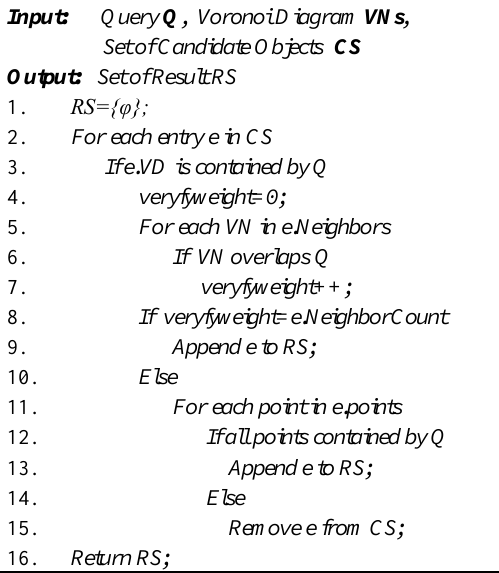
Algorithm 3 . VerifyRangeQuery(Q, VNs, CS)